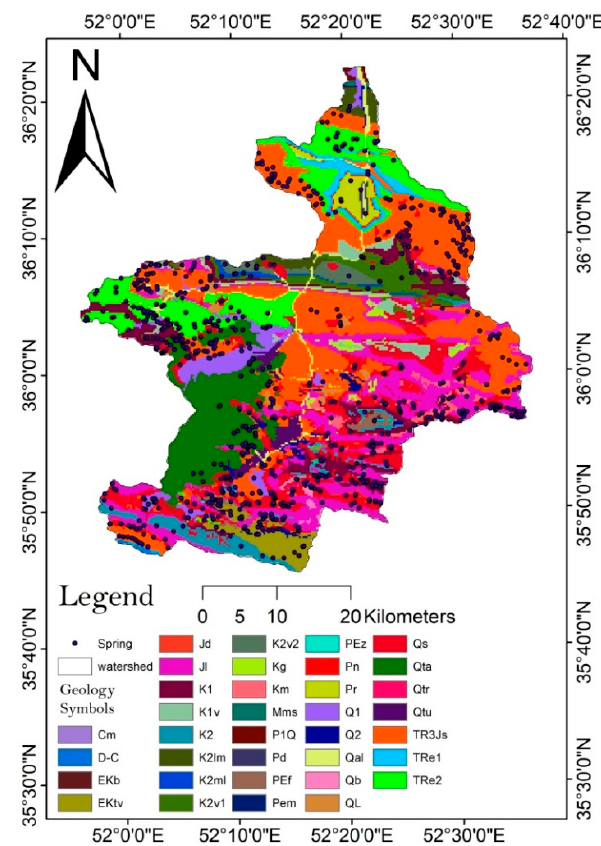
Figure 2. Lithology map of the study area (symbols were defined in Table 1).